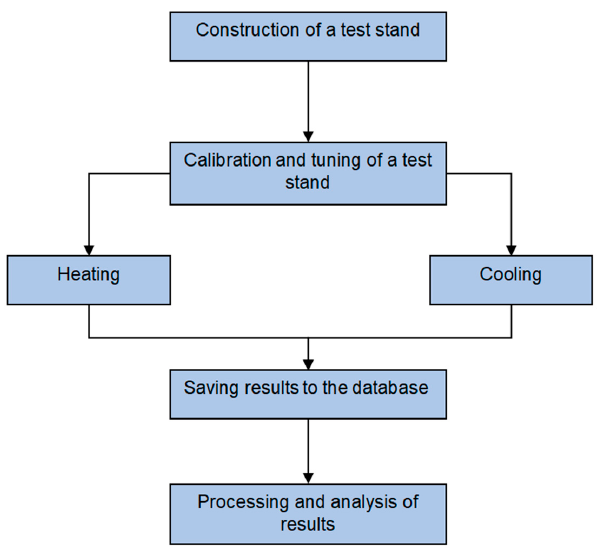
Figure 7. Scheme for implementation of the measurement experiment.